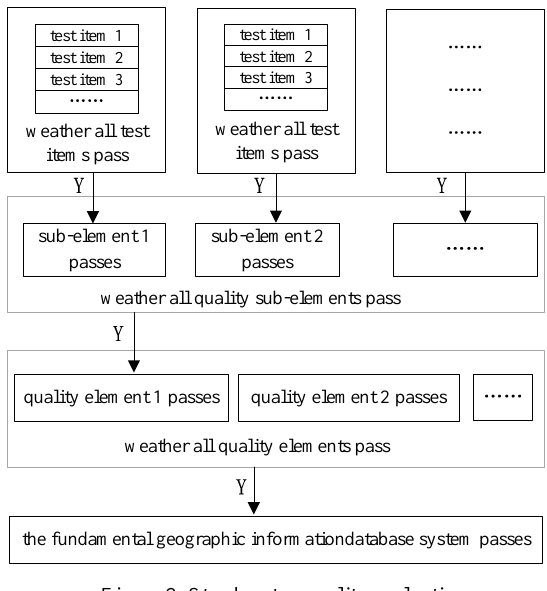
Figure 2. Step by step quality evaluation